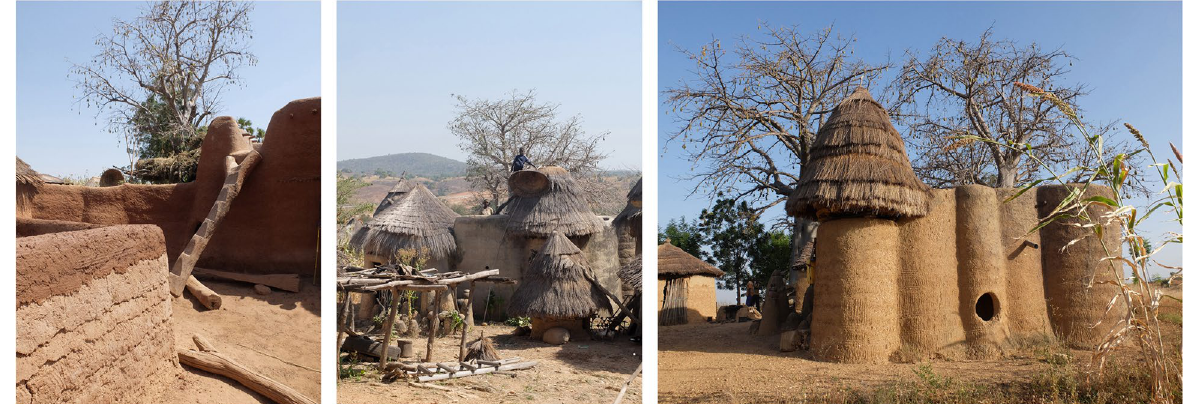
Fig. 1 Architecture of the Koutammakou cultural landscape, Benin (Source: the